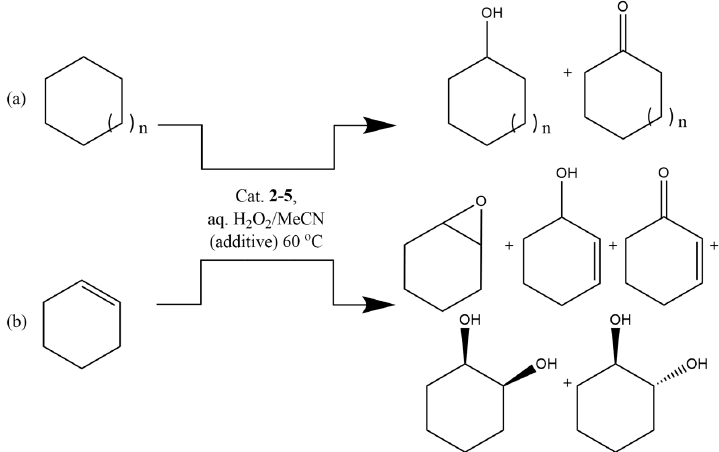
Scheme 2. Peroxidative oxidation of hydrocarbons [( a ) cyclohexane ( n = 1) or cyclooctane ( n = 3) and ( b )